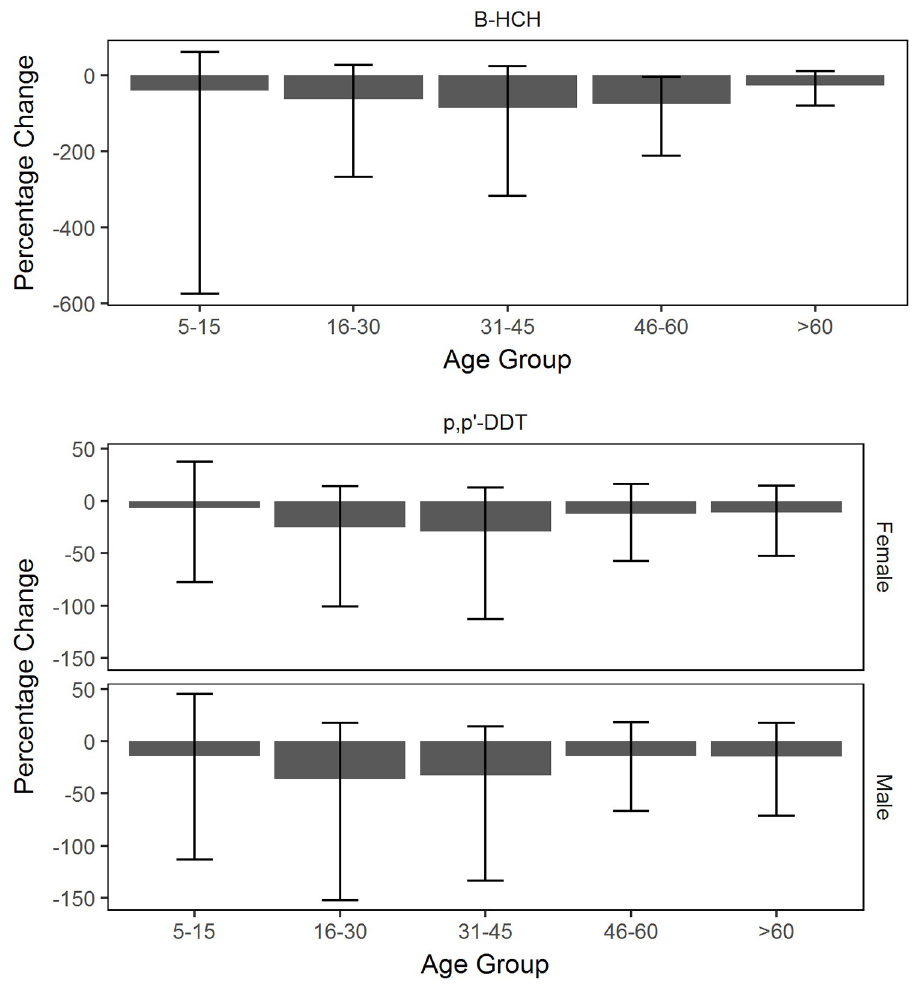
Fig 6. Percent change in OCP concentrations between 2002/03 and 2012/13. The percent change (%) of β -HCH and p,p’ -DDT concentrations (ng/g lipid) between 2002/03 and 2012/13 for age groups 5-15, 16-30, 31-45, 46-60 and > 60. The error bars for each age group indicate the 95% credible interval of the percent change.